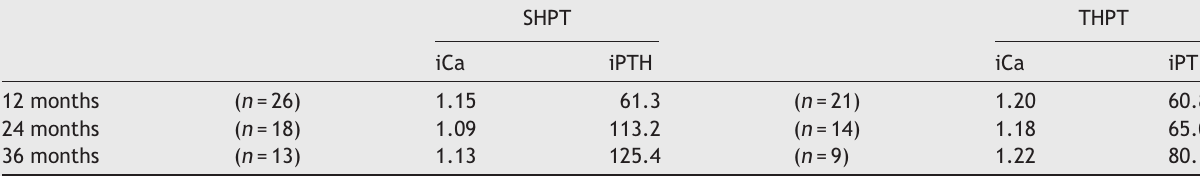
Post-operative mean iCa and iPTH in cured patients in G2-group